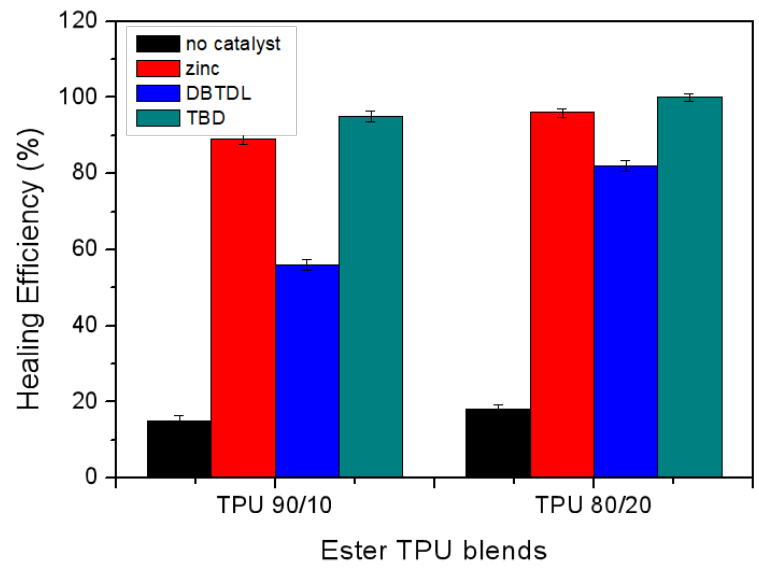
Figure 10. Healing e ffi ciency of ester TPU / phenoxy blends with di ff erent catalysts.